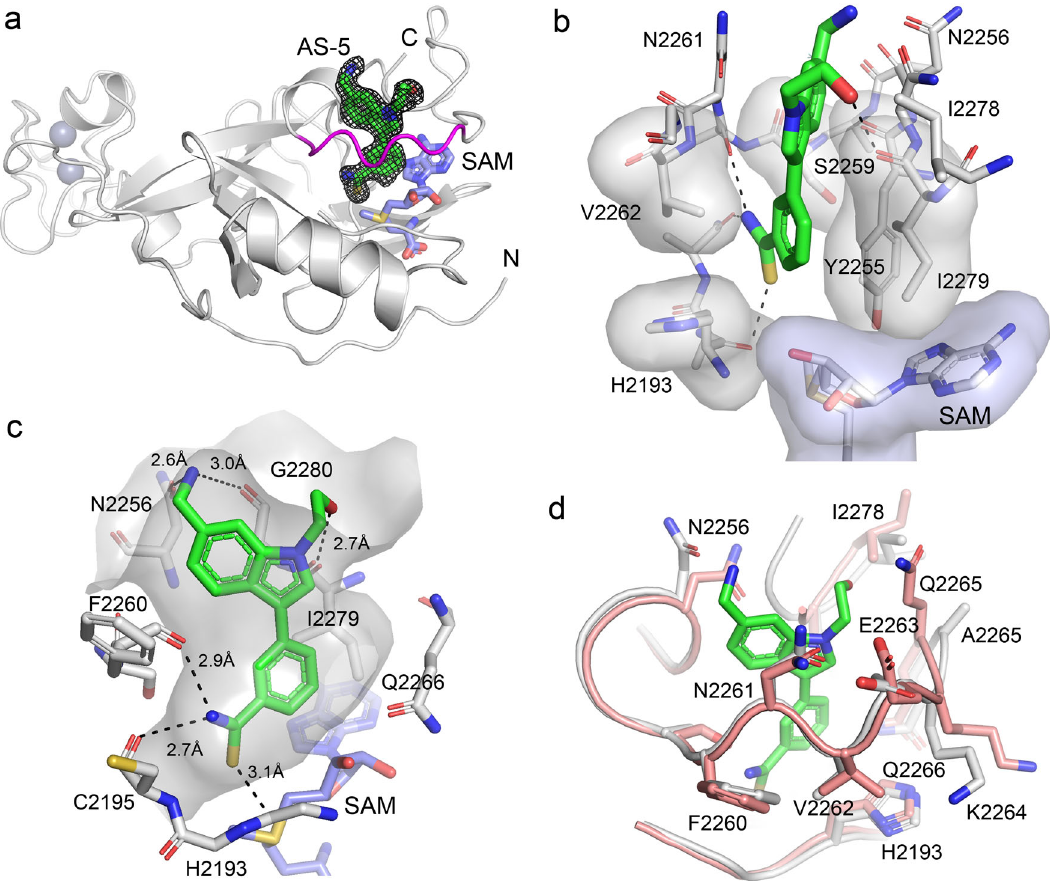
Fig. 3 Crystal structure of ASH1L SET in complex with AS-5. a Overall structure of ASH1L-AS-5 complex with 2Fo-Fc electron density map for AS-5 contoured at the 1 σ level. Protein is shown as ribbon with autoinhibitory loop in magenta and AS-5 shown in sticks with green carbons. b ASH1L residues involved in hydrophobic contacts with AS-5 shown in sticks and transparent surfaces (gray) and SAM is shown in sticks with the blue surface. Hydrogen bonds and chalcogen bonds are shown as dashed lines. Color-coding: AS-5 carbons (green), protein and SAM carbons (gray), oxygens (red), nitrogen (blue), sulfur (yellow). c Details of internal pocket in ASH1L (shown as semi-transparent surface) and binding mode of AS-5 (shown in sticks with green carbons). Selected residues in the ASH1L binding site are shown as sticks with color coding is as in panel ( c ). Hydrogen bonds and chalcogen bonds are shown as dashed lines with distances in Å. d Superposition of ASH1L structure (PDB code 4YNM with salmon carbons) on the structure of ASH1L- AS-5 complex (protein with gray carbons and AS-5 with green